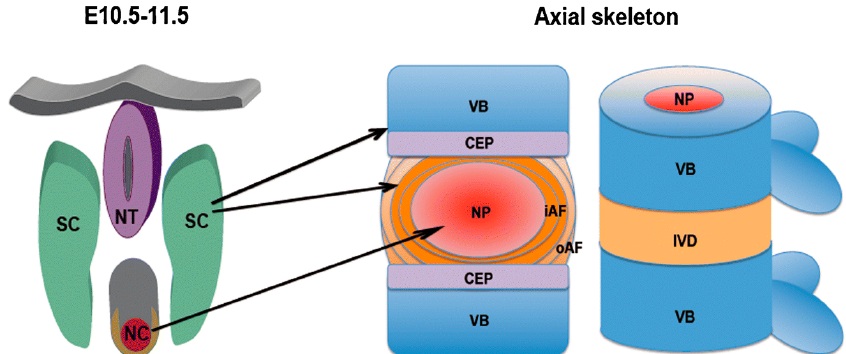
Figure 11. Schematic representation of the development of vertebrae and intervertebral discs from the notochord and the sclerotome. Left: mouse embryo at day 10.5–11.5 of development; right: mature axial skeleton. The nucleus pulposus develops from the notochord, whereas the annulus fibrosus and the other tissues including vertebral body, ligaments, and endplates originate from the sclerotome. NT: neural tube; SC: sclerotome; NC: notochord; VB: vertebral body; IVD: intervertebral disc; NP: nucleus pulposus; iAF: inner annulus fibrosus; oAF: outer annulus fibrosus; CEP: cartilaginous endplate. Reprinted with permission from Reference [106].